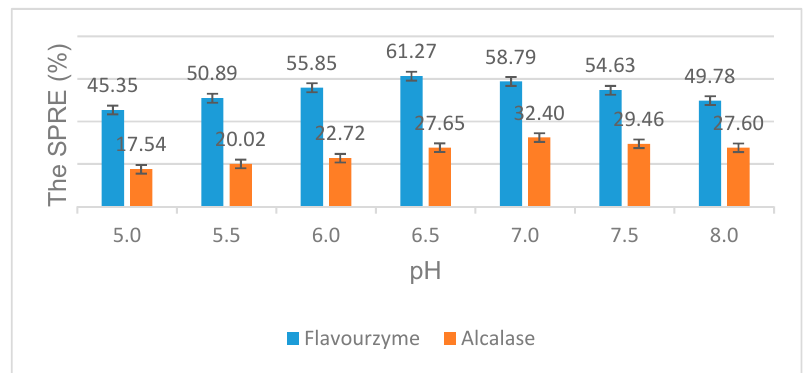
Figure 10. The effect of pH on the SPRE. Figure 10. The e ff ect of pH on the SPRE.